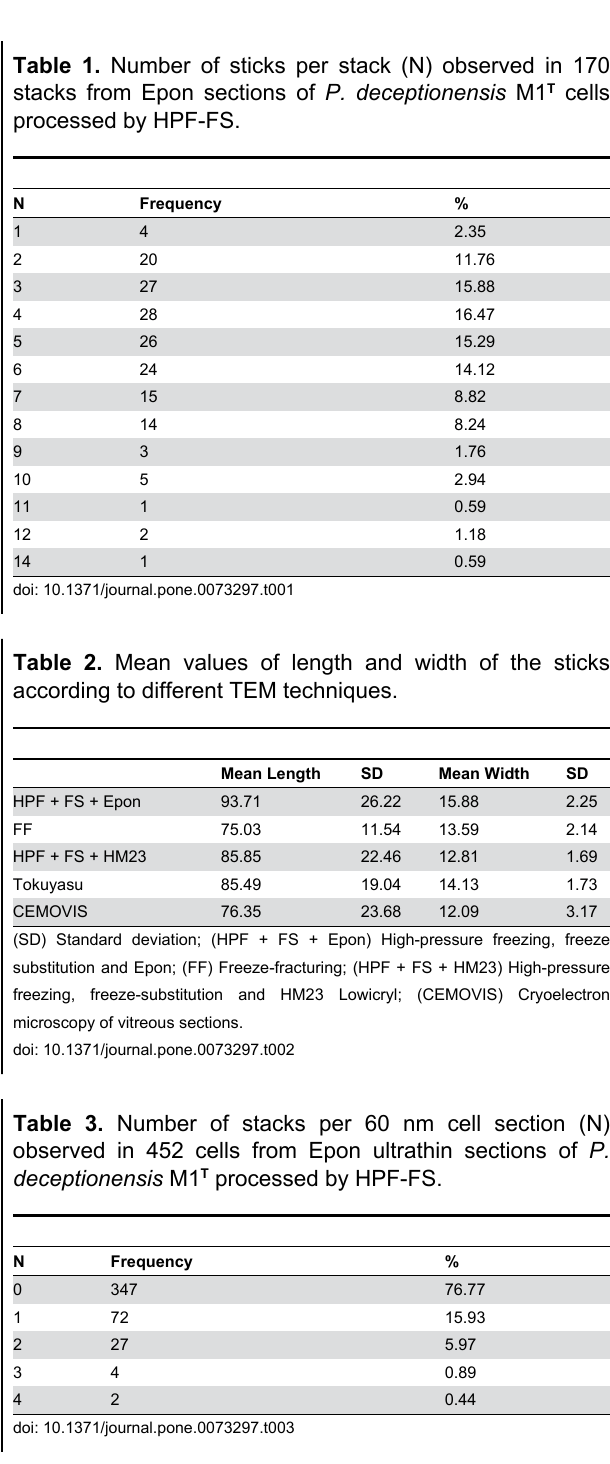
anticontamination glove box as explained below for vitreous sectioning. Squared block faces with side measures ranging from 260 to